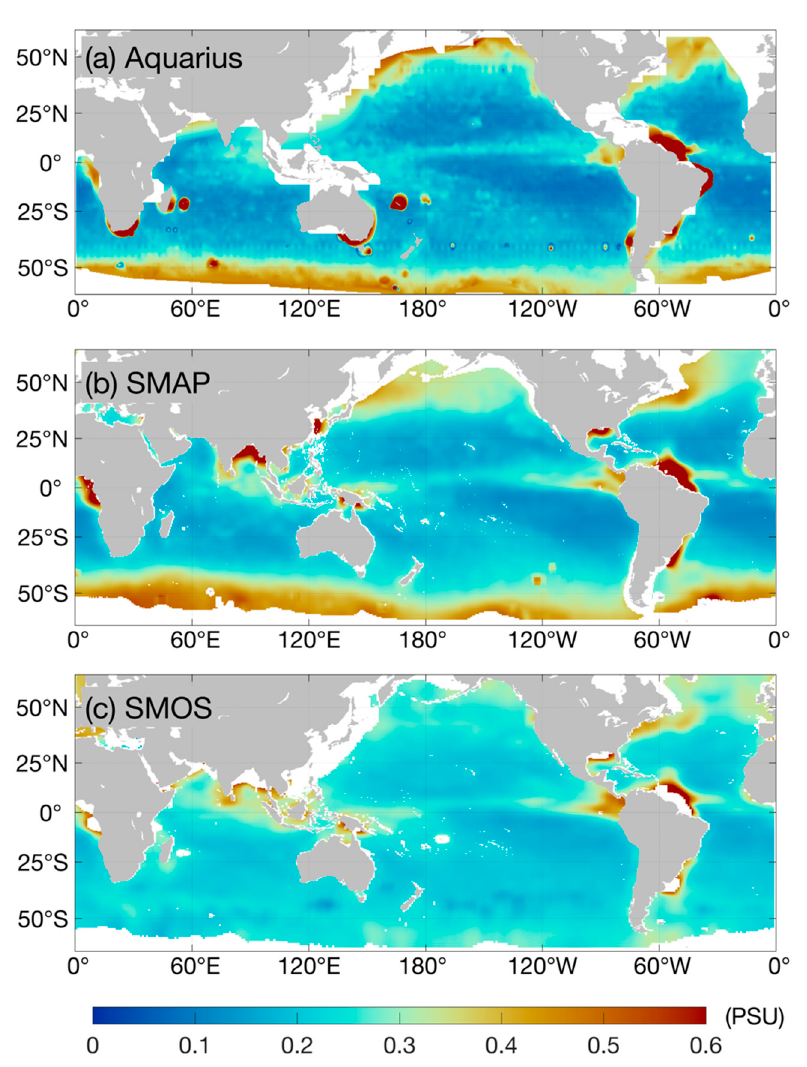
Figure A1. Root mean square of the uncorrelated error estimated from ( a ) Aquarius, ( b ) SMAP and ( c ) SMOS SSS data.